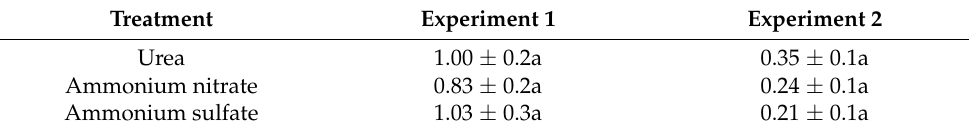
Table 4. Annual N 2 O emission factor (g N per 100 g N